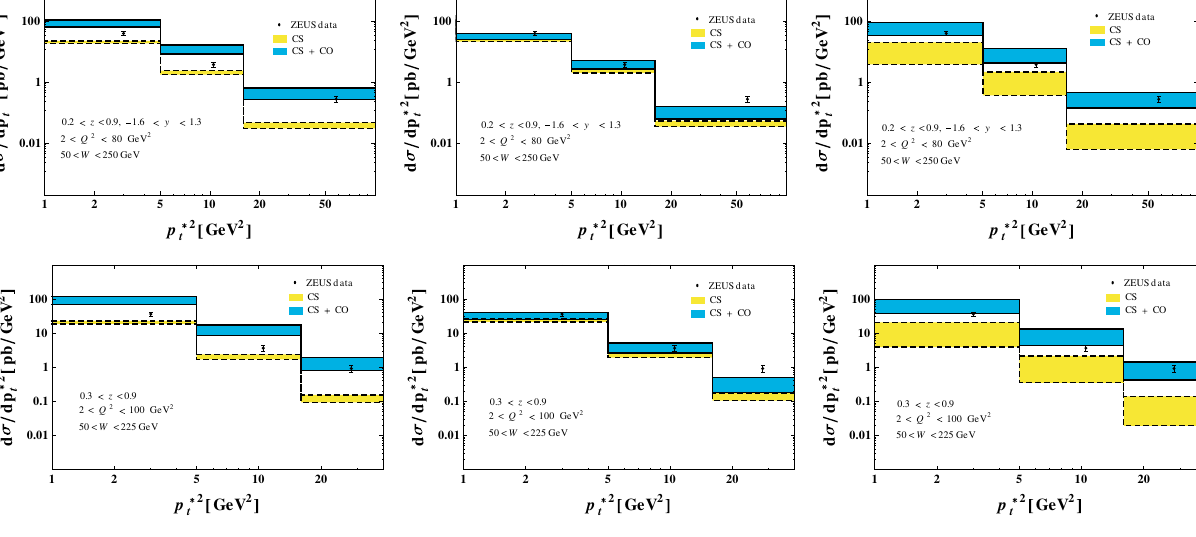
Fig. 4 The differential cross sections for the J /ψ production in DIS with respect to p (cid:11) 2 t . The experimental data are taken from Ref. [51]. The l.h.s., middle, and r.h.s. plots correspond to the LDMEs taken in Refs. [28,30,41],